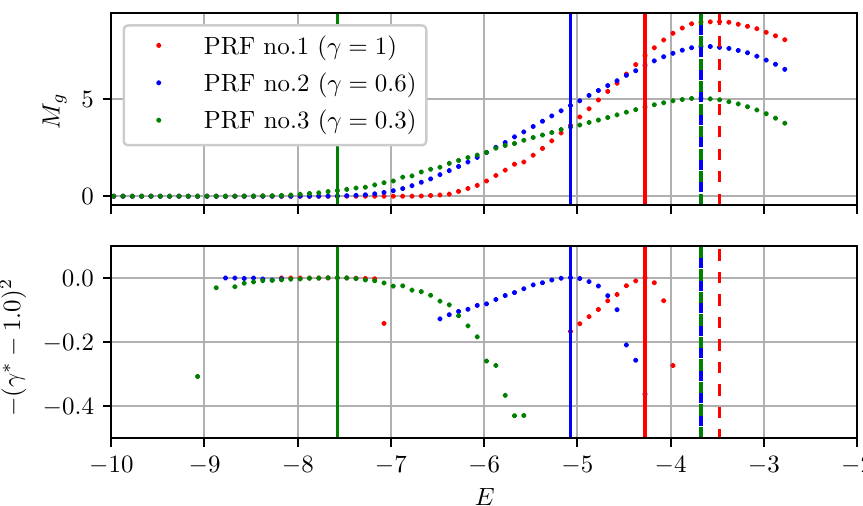
Figure 11. Gradient information metric for different exposure levels of the same static image. Each peak (marked with discontinuous vertical lines) corresponds to the true optimal exposure level. Peaks for the bottom graph (marked with continuous vertical lines) correspond to the optimal exposure levels predicted by Shim’s γ transformations [16]. Each colored curve represents a different camera’s